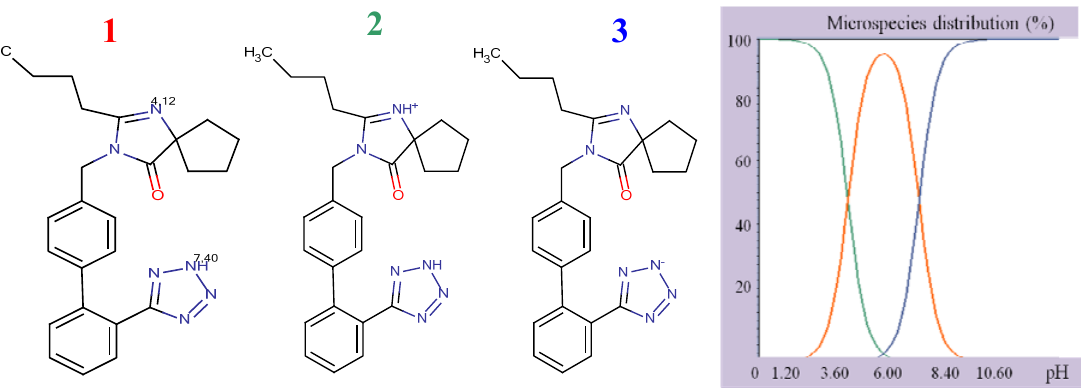
Figure 4. Structural formulae of ionized